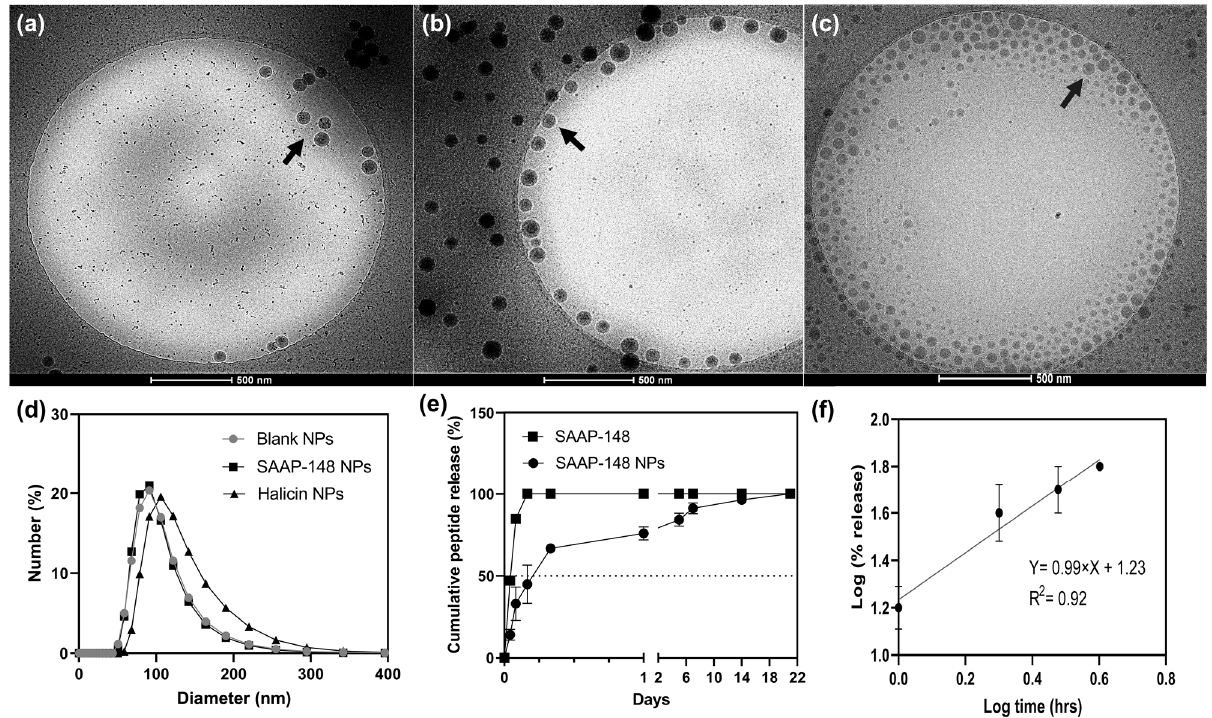
Figure 1. Physiochemical properties of PLGA NPs formulated using the solvent evaporation double emulsion technique. Representative images acquired with Cryo-EM of ( a ) blank PLGA NPs, ( b ) SAAP-148 NPs, and ( c ) halicin NPs. Scale bar = 500 nm. Arrows indicate spherical nanoparticles formulated with the double emulsion technique under identical formulation parameters. ( d ) The particle size distribution obtained with dynamic light scattering (DLS) representing (circles) blank PLGA NPs, (squares) SAAP-148 NPs, and (triangles) halicin NPs. ( e ) Peptide release profile over a period of 21 days, from (circles) SAAP-148 NPs and SAAP-148 solution (squares), using a Float-A-Lyzer in PBS at 37 °C. The concentration of peptide in the outer compartment of the Float-A-Lyzer, filled with free peptide in the inner compartment and expressed as % of the initial concentration, is indicated by squares. The dashed line indicates the 50% peptide release cut-off point. ( f ) Fitting the first log 60% of peptide release (%) by log time (h) into the Korsmeyer–Peppas Model to determine mechanism governing release from SAAP-148 NPs. Data are provided as the mean and standard deviation of three independent experiments performed in duplicates.